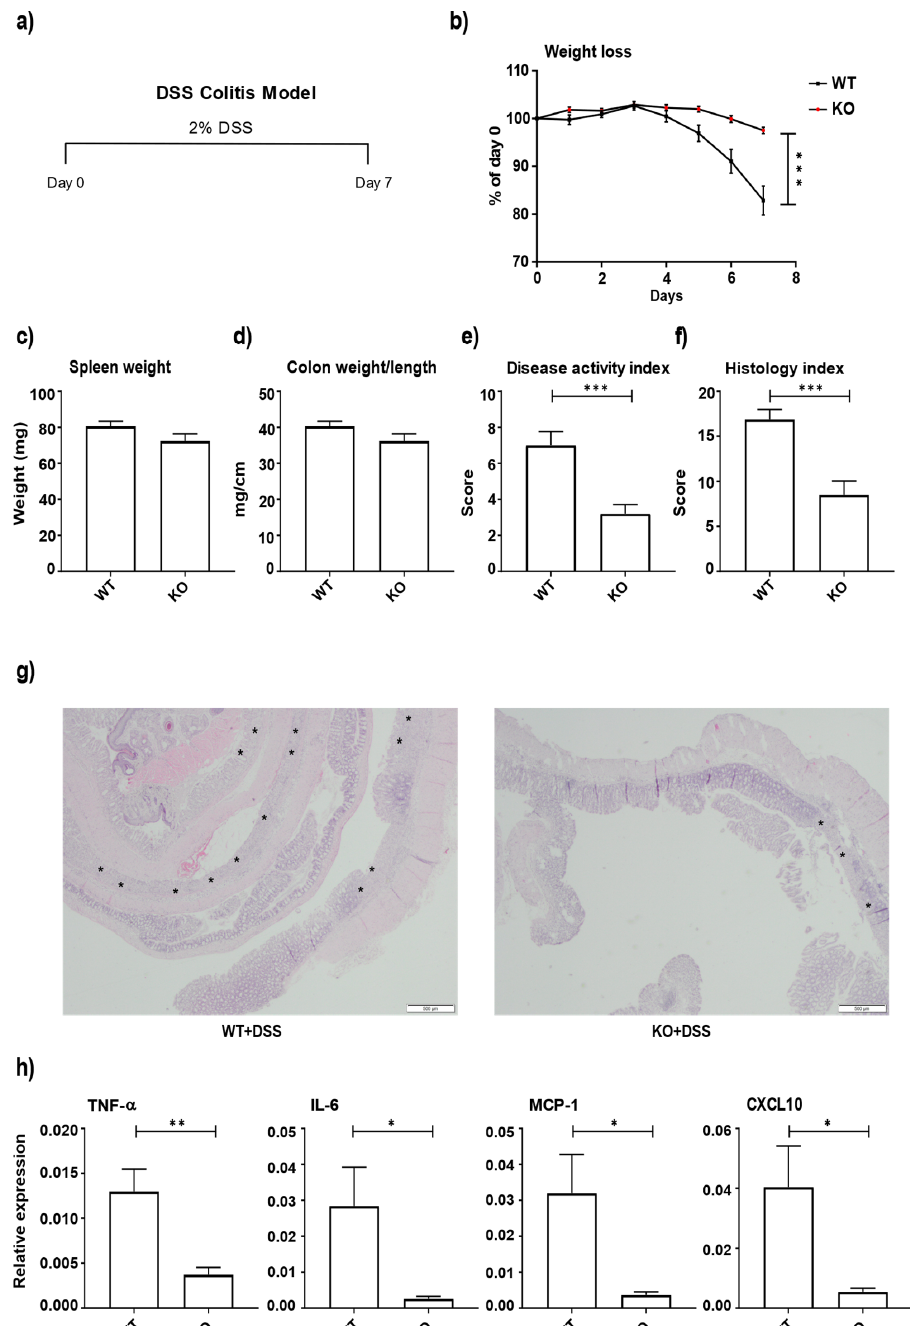
Figure 2. miR-511 deficiency ameliorate DSS-induced colitis. ( a ) A schematic presentation of DSS colitis in mice. ( b ) Bodyweight changes between WT and miR-511-deficient mice after colitis induction. ( c ) Spleen weights. ( d ) Colon weight/length ratio. ( e ) Disease activity index score. ( f ) Colitis histology index score. ( g ) Representative histology picture of colons from WT and miR-511-deficient mice, 2× magnification, asterisk represents erosion and ulceration ( h ) mRNA expression of TNF- α , IL-6, MCP-1, and CXCL10 in colon homogenates of all groups by qPCR. N = 9 WT and 10 miR-511-deficient mice for ( b – f , h ). mRNA levels were normalized for their reference genes. Individual values are expressed as mean and standard error of the mean. Statistical differences were tested by independent t -test, where a p -value of <0.05 was considered to be significant. * p -value < 0.05; ** p -value < 0.01 and *** p -value <